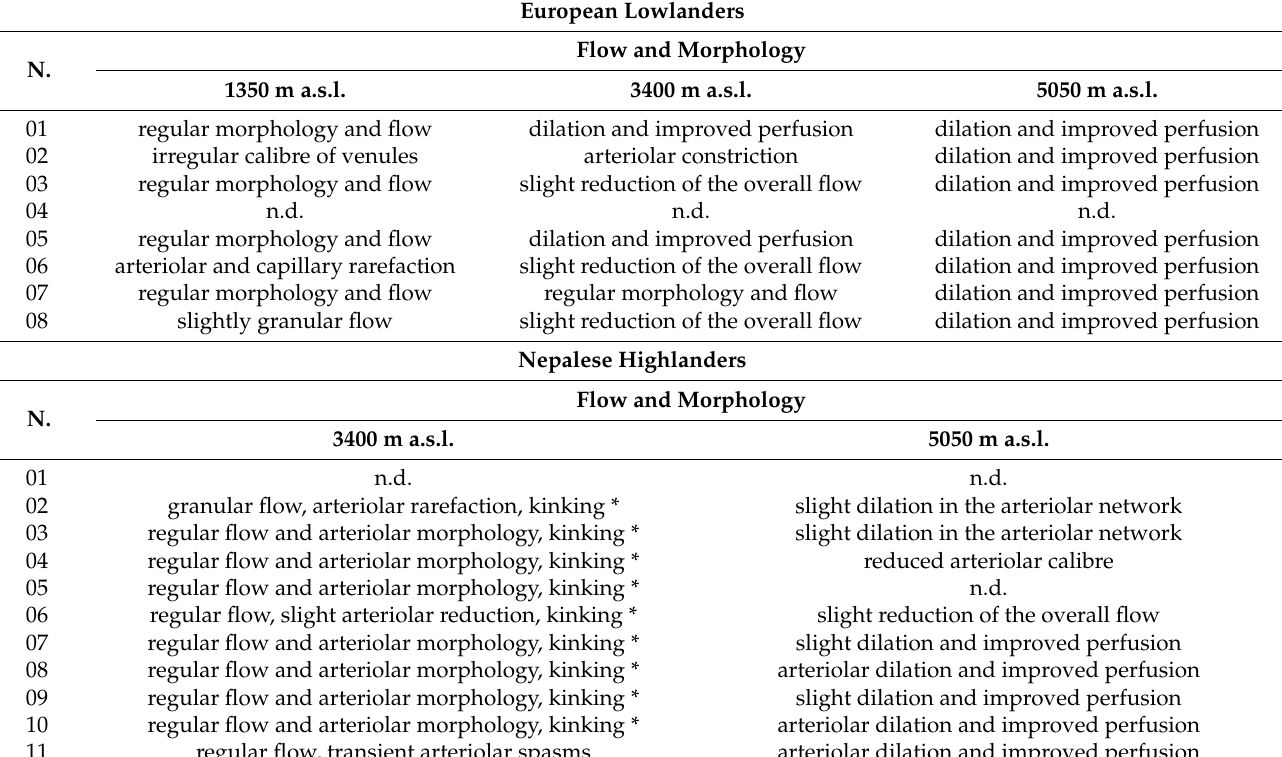
Table 5. Microvascular change with altitude. Conjunctival